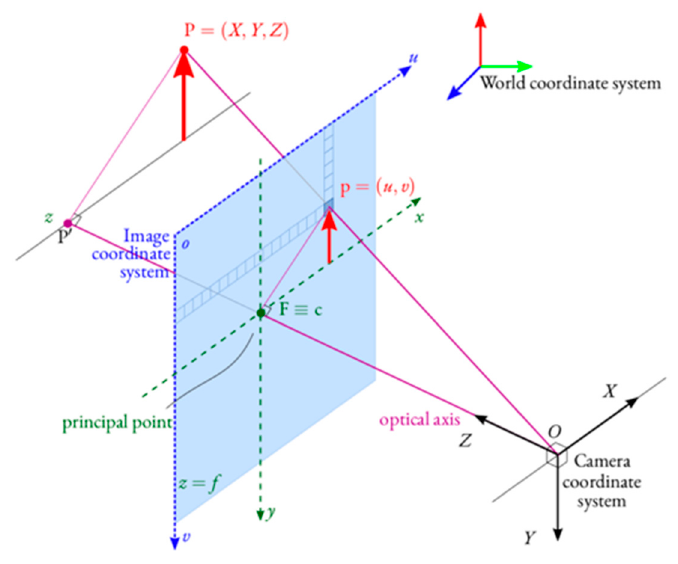
Figure 4. Pinhole camera model.